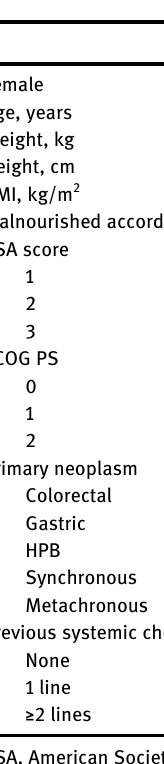
Table  : Baseline characteristics of the study